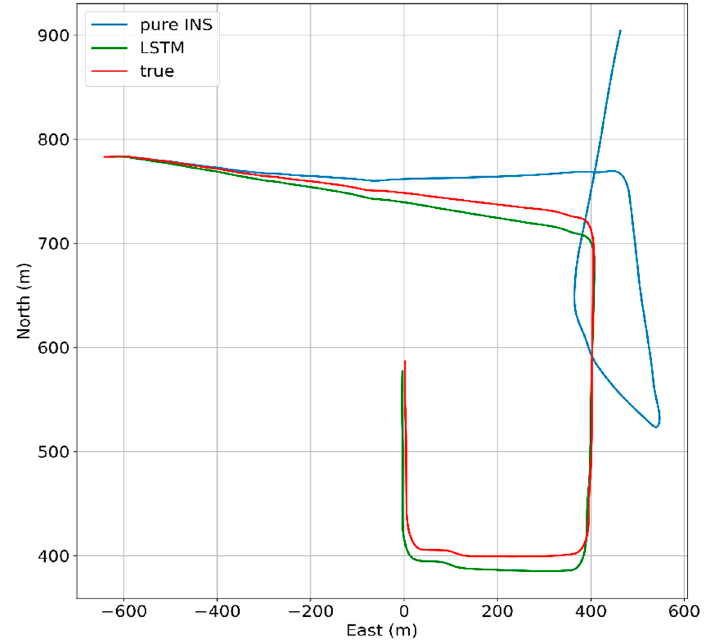
Figure 23. LSTM 180 s outages trajectory.